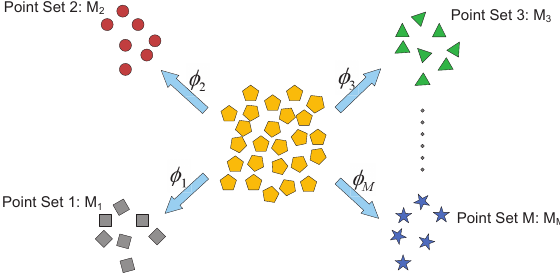
Figure 5. The forward approach of groupwise point set registration method in [108].